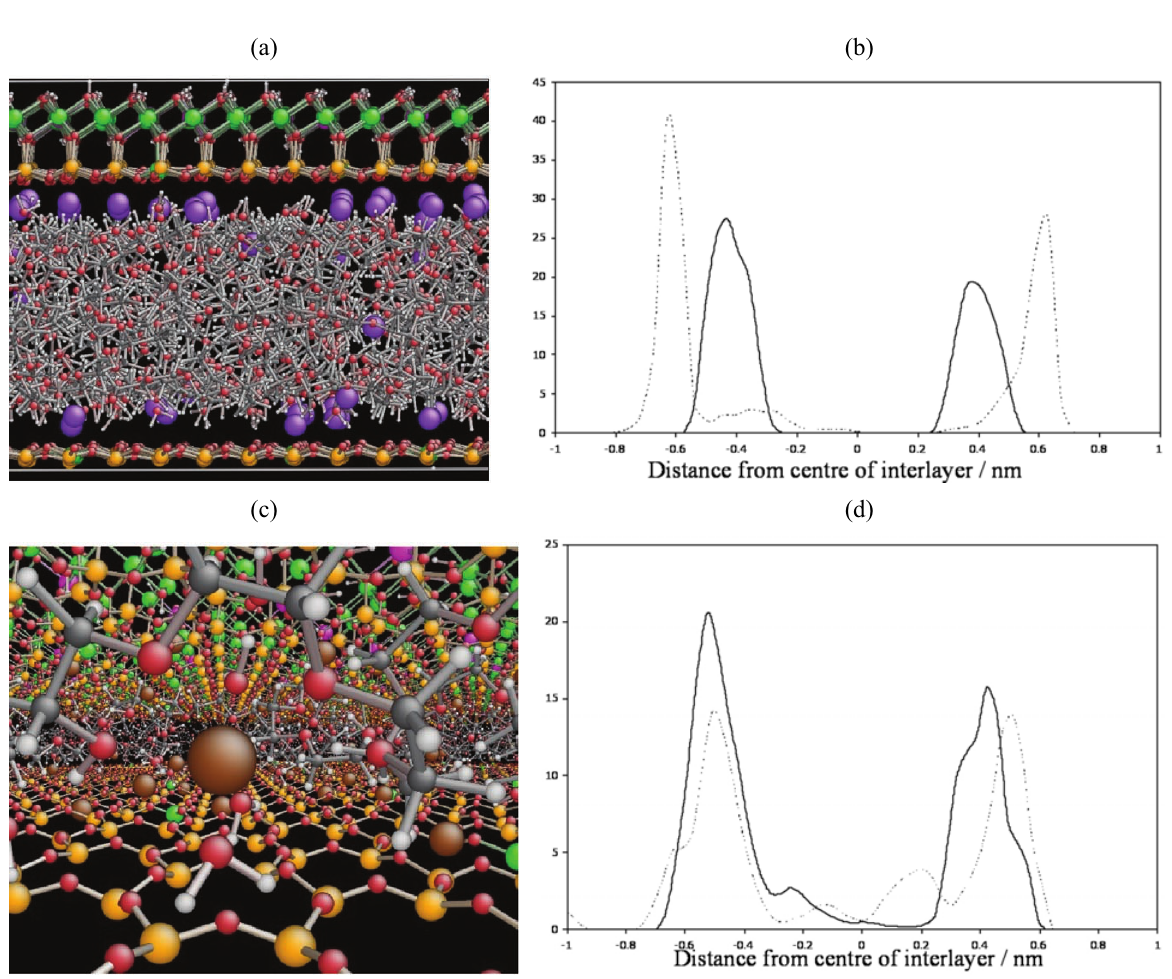
Fig. 4 – Snapshots after 1 ns of molecular dynamics simulation for (a) the PEG–K + Mmt composite and (c) the PEG–Na + Mmt composites. The one-dimensional atom density maps of the change in K + cation distribution for the simulated PEG and PEO–DiAc K + Mmt composites is shown in (b) and the change in Na + cation distribution for the simulated PEG and PEO-DiAc Na + –Mmt composites in (d). The x -axes show the distance from the centre plane of the interlayer in nm ( × 10 ) . The y -axes show the arbitrary density. Dashed line = poly(ethylene glycol) and solid line = poly(ethylene oxide) diacrylate for